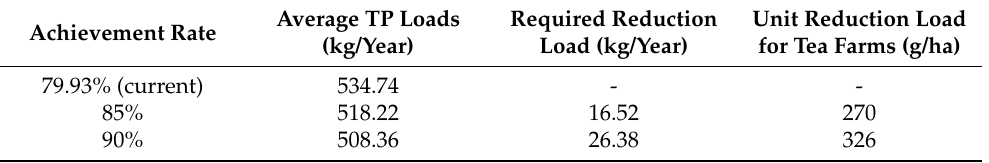
Table 4. The unit TP reduction loads of tea farms required to match the target goal: 85% and 90% water quality achievement